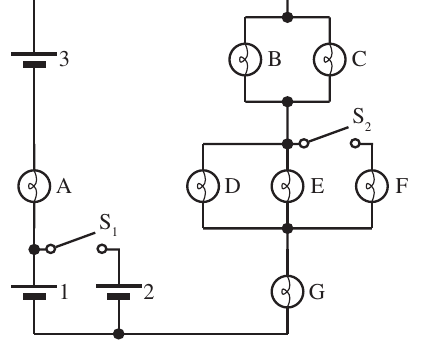
FIG. 4. Circuit diagram used in the multiple batteries in a single loop